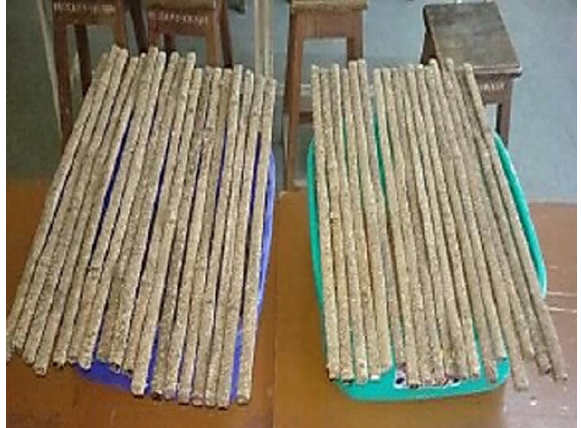
Figure 10. Bamboo reinforcement bars used in concrete slabs. Reprinted with permission from [102]. Copyright©2018, Elsevier B.V.